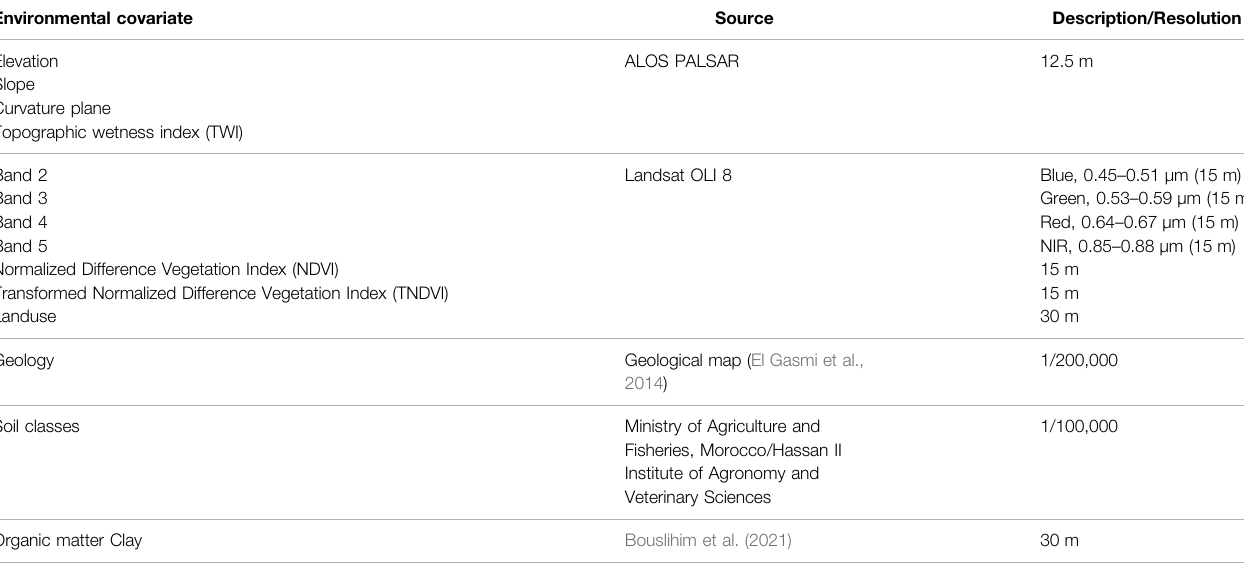
TABLE 1 | Environmental covariates for soil aggregate stability